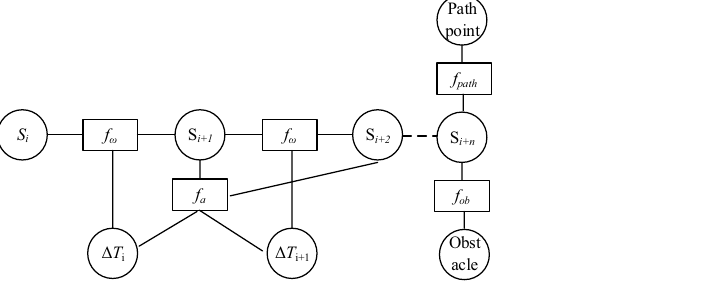
Figure 10. The improved